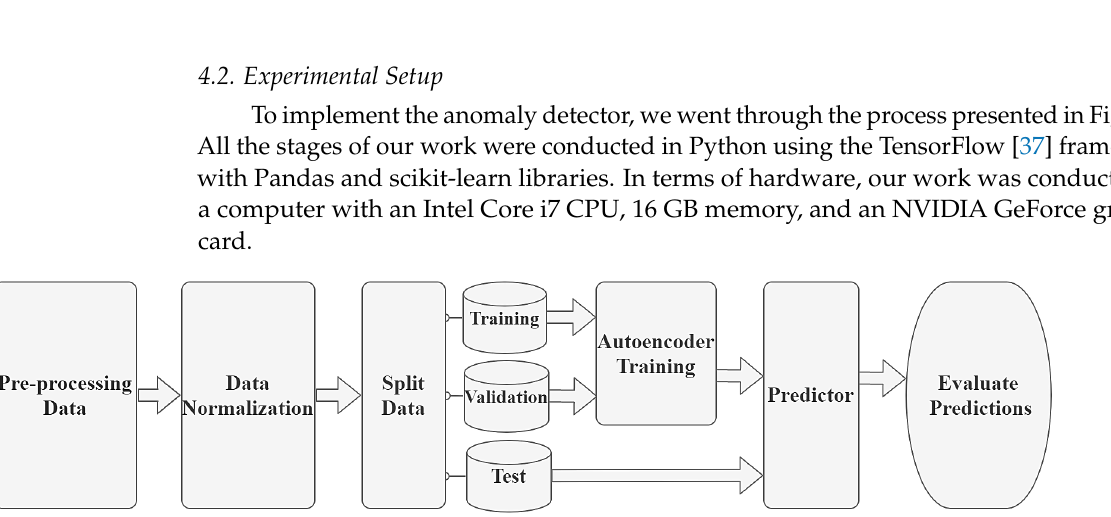
Figure 3. Experimental